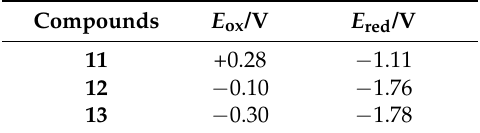
Table 2. Redox potentials (V vs Fc/Fc + ) of 11 , 12 , and 13